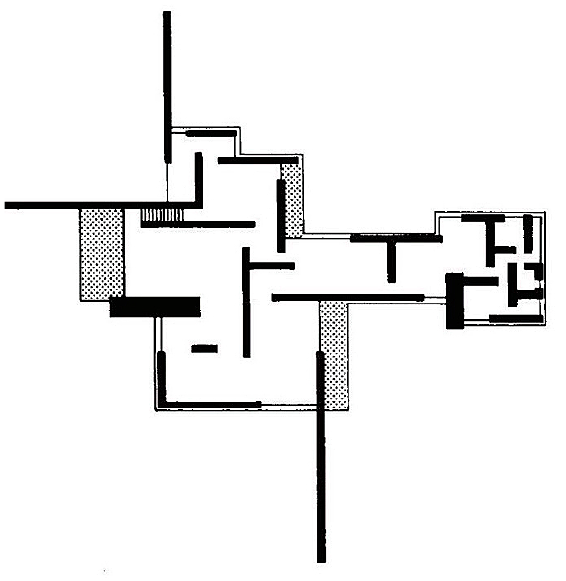
fig. 6. Mies van der rohe, Plan of Brick Country House, 1924, neubabelsberg, Germany (from Colquhoun, 2002)